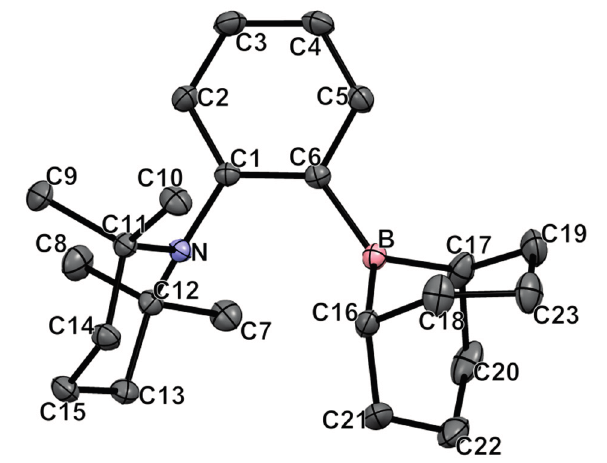
Figure 1. ORTEP diagram of compound 1 . Thermal ellipsoids are drawn at 50% probability. Hydrogen atoms are omitted for clarity. Selected bond lengths (Å) and angles (deg): B-C6 = 1.576(1); N-C1 = 1.442(1); B-N = 3.053(1); C6-B-C16 = 128.25(8); C6-B-C17 = 120.77(8); C16-B-C17 = 110.10(8); C12-N-C11 = 119.27(7); C12-N-C1 = 115.52(7); C11-N-C1 = 115.87(7); N-C1-C6 = 119.67(8); B-C6-C1 =